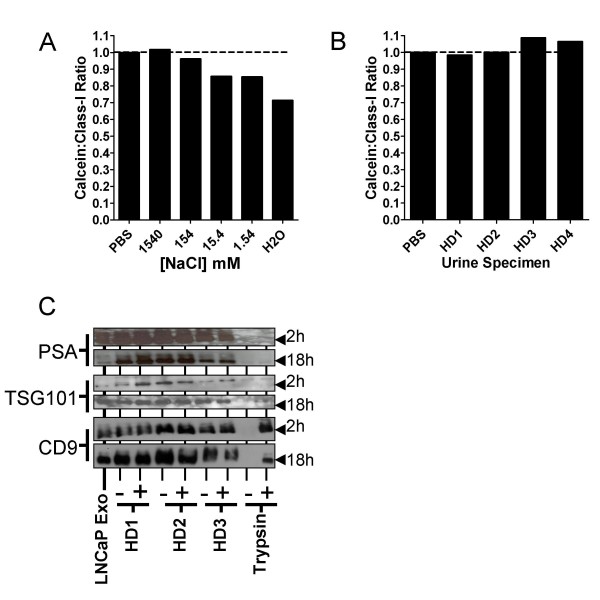
Evaluating urine-mediated damage of exosomes. Exosomes coupled to microbeads were labelled with a luminal fluorescent dye (Calcein-AM), prior to incubation with various concentrations of NaCl (A) or with fresh urine specimens from four healthy donors (HD1-4) (B). In parallel, identical beads were set up, in the absence of Calcein-AM dye, stained instead with anti-MHC Class-I (RPE) conjugated antibody. After 1 h at room temperature, the fluorescence signal present in the FL-1 channel (Calcein) was compared to FL-2 fluorescence (Class-I-RPE). Graphs show ratio of Calcein to Class I fluorescence. To examine proteolytic damage of exosomes (C), western blot was performed for CD9, TSG101 and PSA on LNCaP-derived exosomes; which were incubated for 2 h or 18 h with fresh urine specimens (from three healthy donors), in the presence or absence of protease inhibitors. Trypsin was used as a positive control for proteolysis.